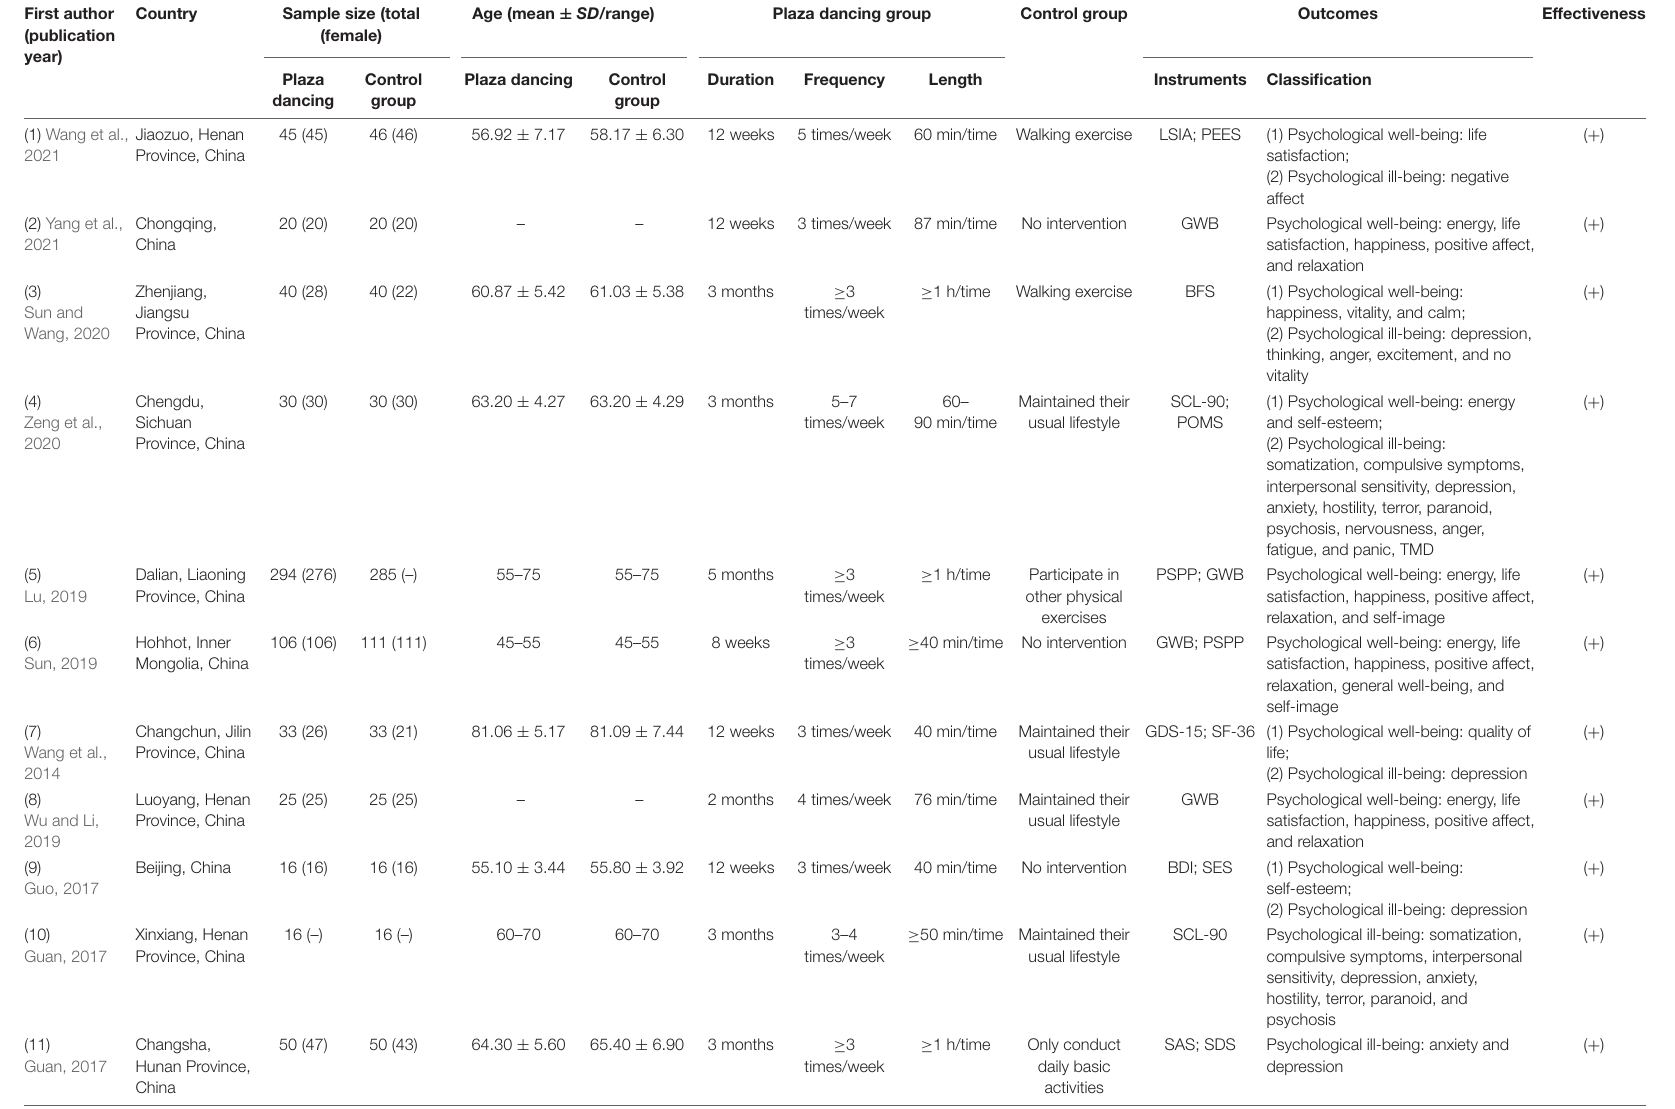
TABLE 1 | Main characteristics and findings of the association between plaza dancing and psychological well-being or/and